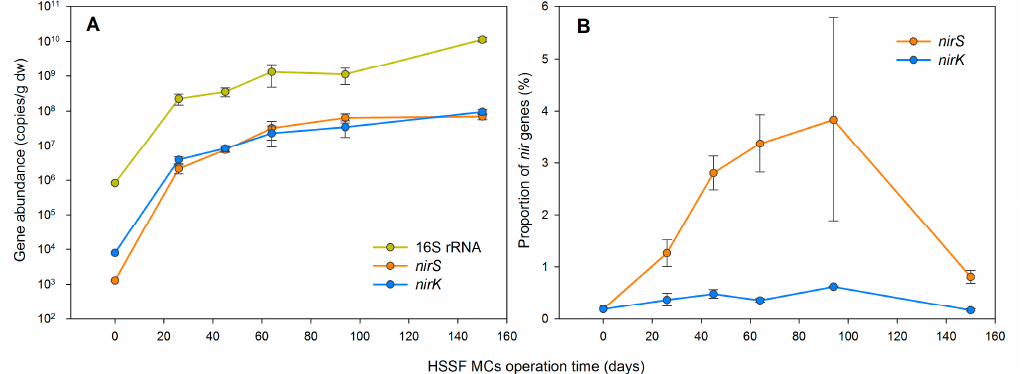
Figure 1. Dynamics of ( A ) bacterial 16S rRNA, nirK and nirS gene abundances; and ( B ) proportions of nirS and nirK genes in the HSSF wetland media biofilm (WMB) bacterial community. Shown are average values and standard deviation ( n =